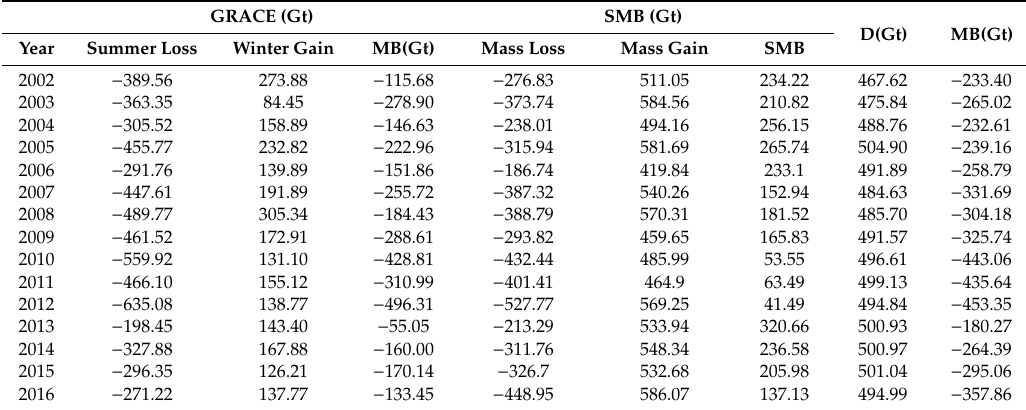
Table 2. Mass changes from the GRACE and SMB minus ice discharge (SMB-D) estimates during the period 2002 to